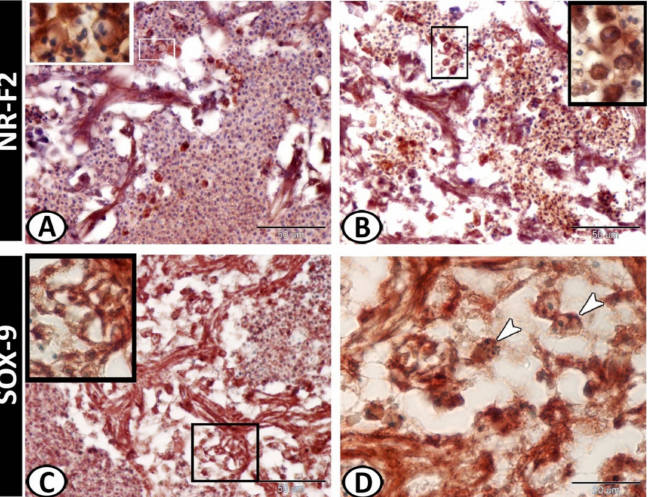
Figure 7. Immunohistochemistry of NR-F2 and Sox-9 in the spleen. ( A ) NR-F2 was expressed in stem cells (boxed areas). ( B ) NR-F2 was expressed in the rodlet cells (boxed areas). ( C ) Sox-9 was expressed in epithelial reticular cells (boxed areas). ( D ) Sox-9 showed immunoreactivity in the stem cells